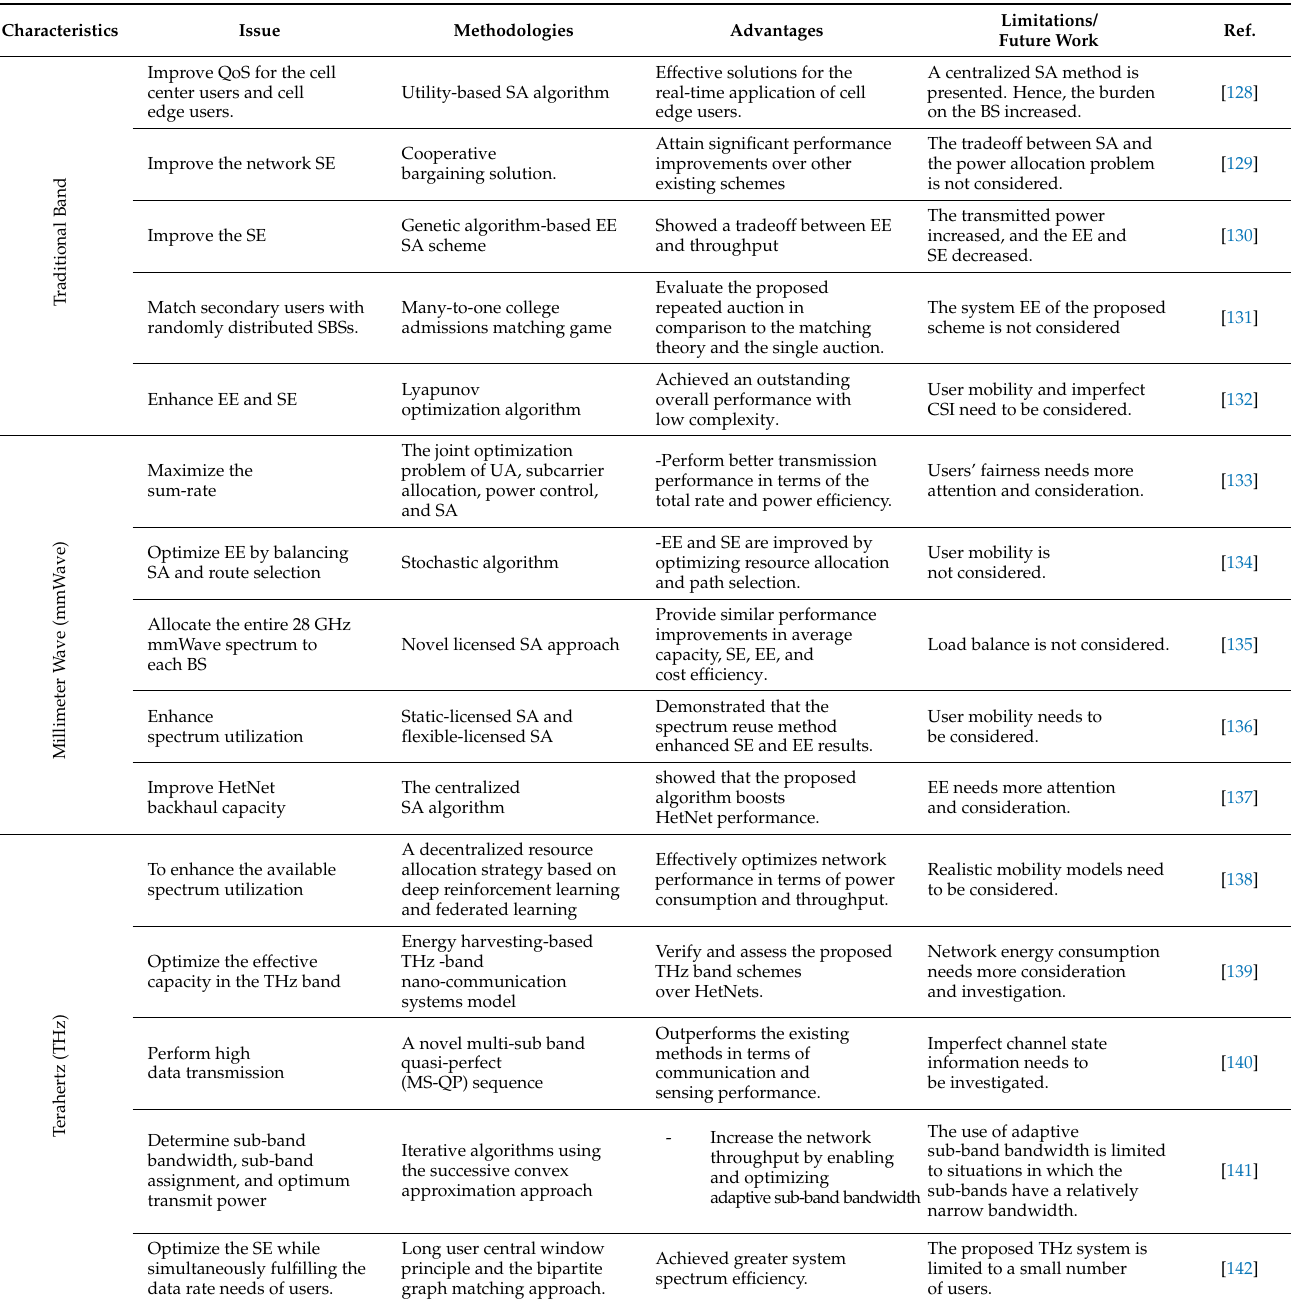
Table 5. Summary of the related work for spectrum